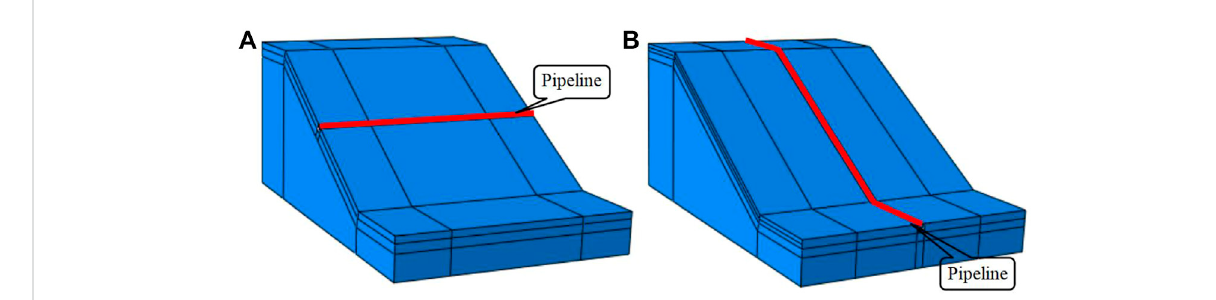
Schematic diagram of different conditions of pipelines crossing landslides.